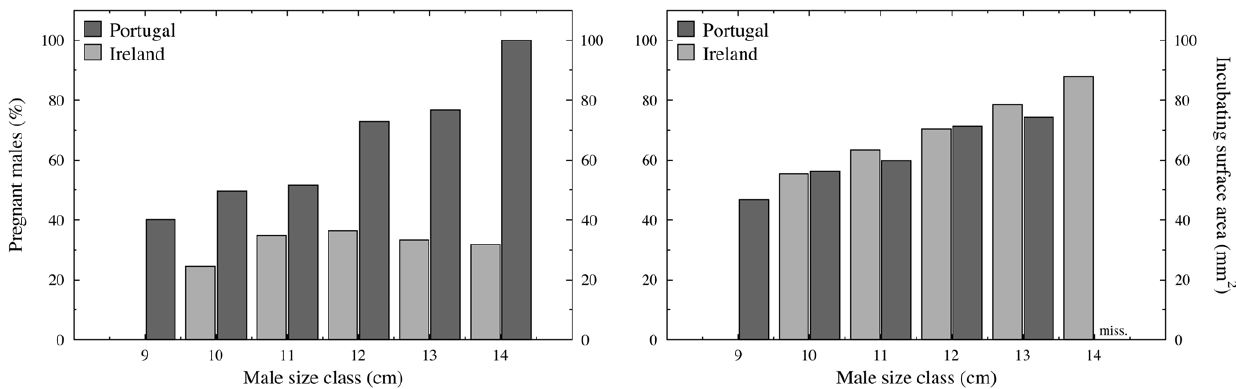
Figure 5. The annual percentage of pregnant males according to size class (left plot) and the average brooding surface area (right plot), in Ireland (light grey) and Portugal (dark grey; ‘‘miss.’’ indicates missing values).